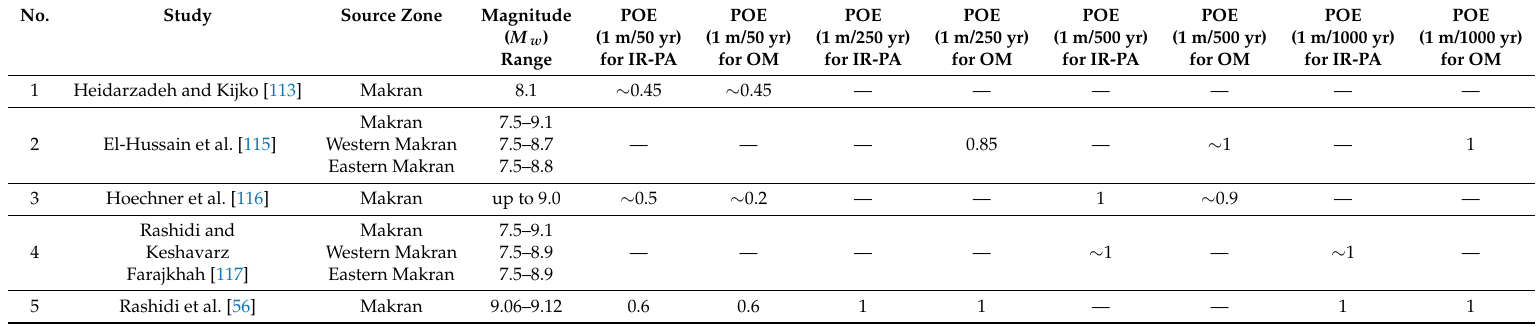
Table 2. Comparison between estimated maximum values of probability of exceedance (POE) along the coastlines of Iran-Pakistan (IR-PA) and Oman (OM) from different PTHA